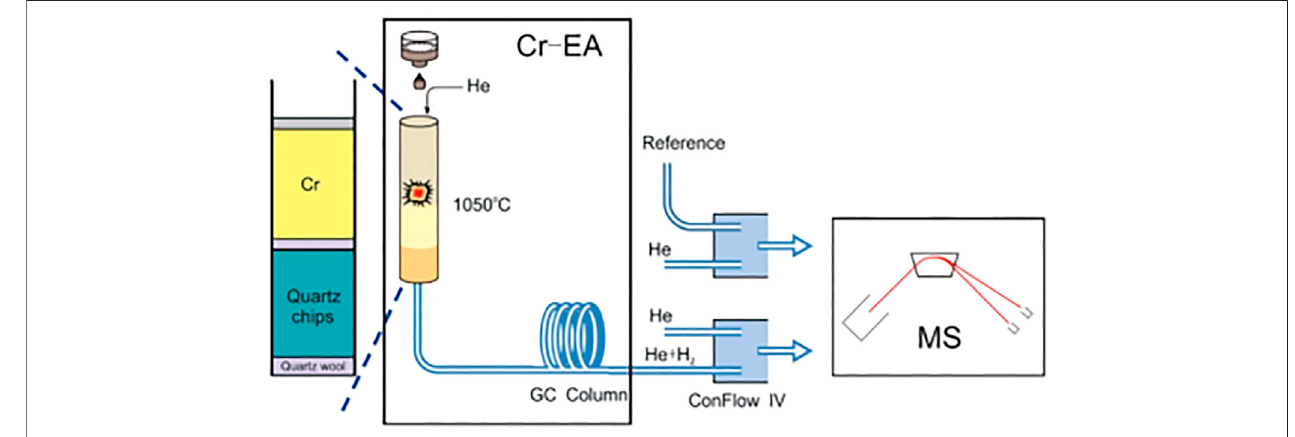
FIGURE 1 | Simpli fi ed sketch of the analytical system for hydrogen isotope